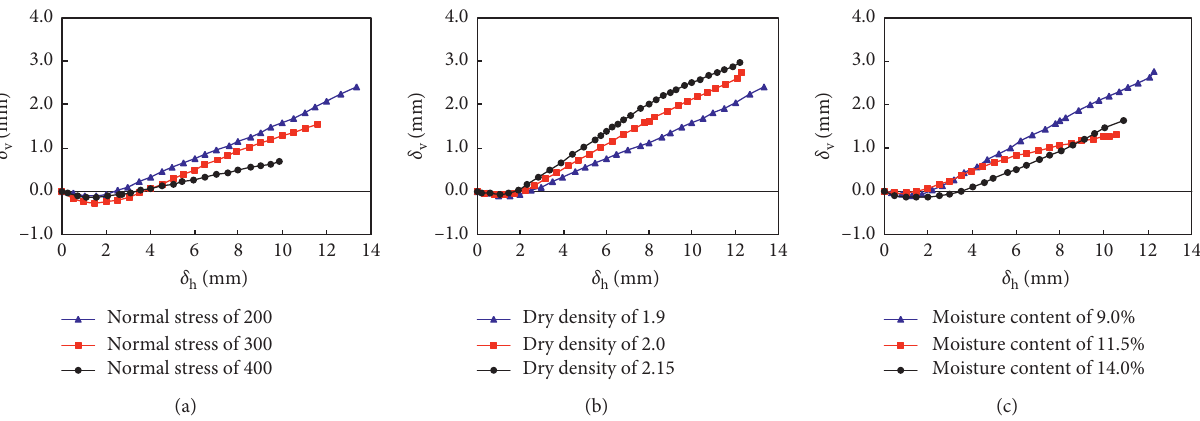
Figure 6: Variation of vertical displacement ( δ σ � 200kPa. (c) ρ d � 2.0g/cm 3 , σ �